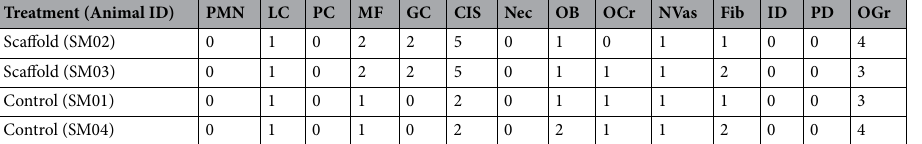
Table 4. Histopathology scores for individual animals. Graded categories are polymorphonuclear cells (PMN), lymphocytes (LC), plasma cells (PC), macrophages (MF), giant cells (GC), cumulative inflammation score (CIS); the sum of scores assigned to PMN, LC, PC, MF, and GC categories; maximum possible score = 20), necrosis (Nec), osteoblast cells (OB), osteoclast remodeling (OCr), neovascularization (NVas), fibrosis (Fib), implant degradation (ID), paticulate debris (PD), and osteogenic response